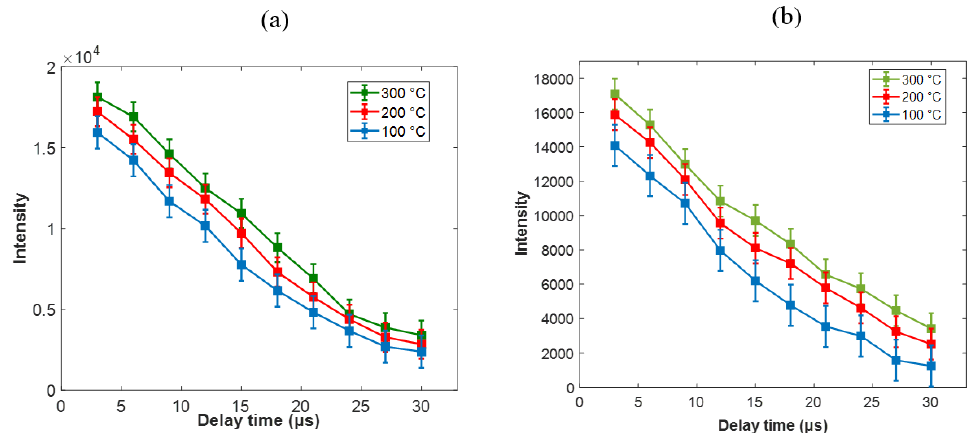
Figure 6. ( a ) Time-resolved emission line of Mg I-518.4 nm for di ff erent sample temperatures of 100, 200 and 300 ◦ C at laser fluence of 18.1 J cm − 2 . ( b ) Time-resolved emission line of Ti II–376.2 nm for di ff erent sample temperatures of 100, 200 and 300 ◦ C at laser fluence of 18.1 J cm − 2